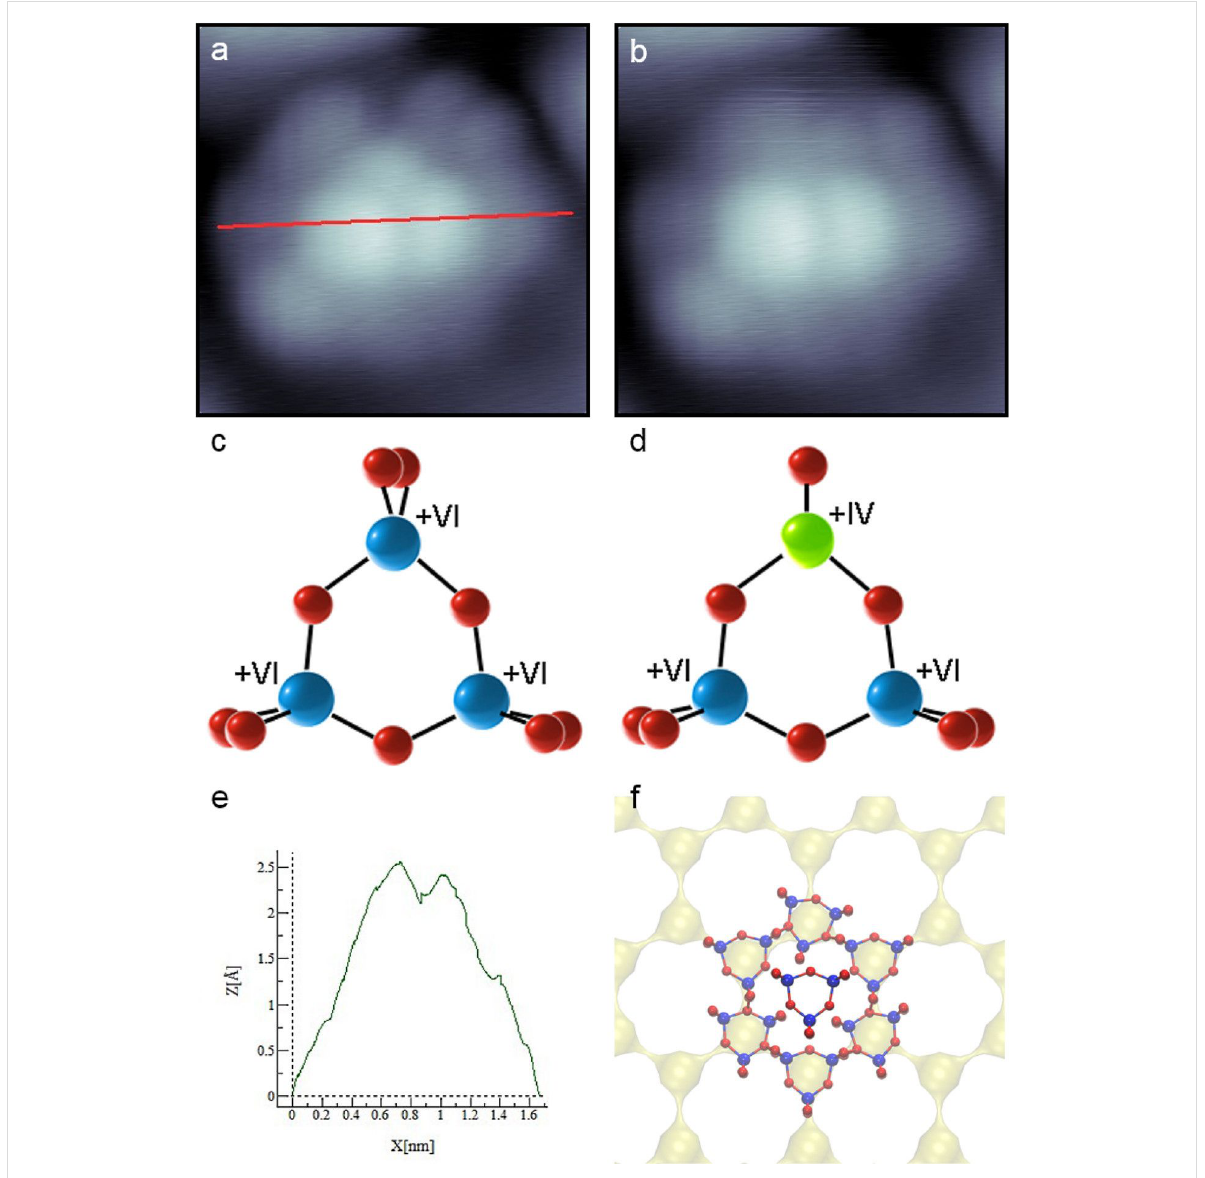
Figure 3: High-resolution STM images (both 1.8 × 1.8 nm; U B = 0.50 V; I T = 62 pA) of a supramolecular assembly of W 3 O 9 molecules on the w’-TiO x phase grown on Pt 3 Ti(111) before (a) and after (b) an intermediate scan with U B = − 1.00 V and I T = 40 pA. By this procedure, the appearance from the top-laying molecule changed from a three-lobe to a two-lobe structure, indicating a partial reduction of one of the tungsten atoms resulting in W 3 O 8 . Panels (c) and (d) illustrate the proposed structures before and after the procedure. The graph in (e) shows the corresponding height profile of the W 3 O 9 stack in (a) marked by the red line. Panel (f) illustrates the proposed orientation on the w’-TiO x phase grown on Pt 3 Ti(111).